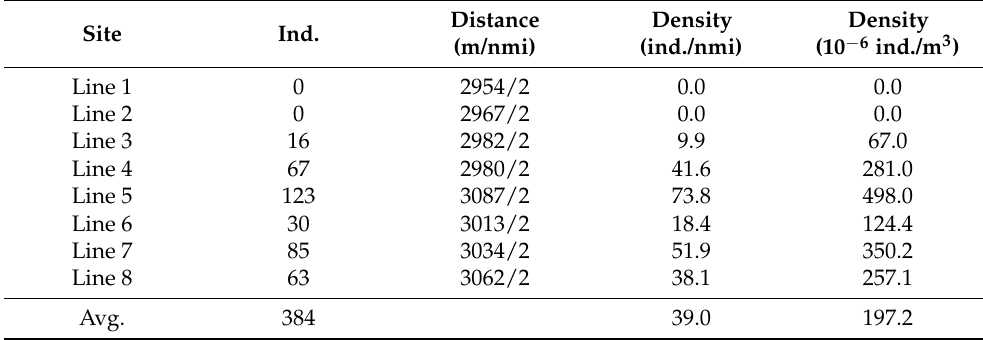
Table 15. Distribution density of jellyfish using the sighting method in the Gijang coastal waters sea (7/23).